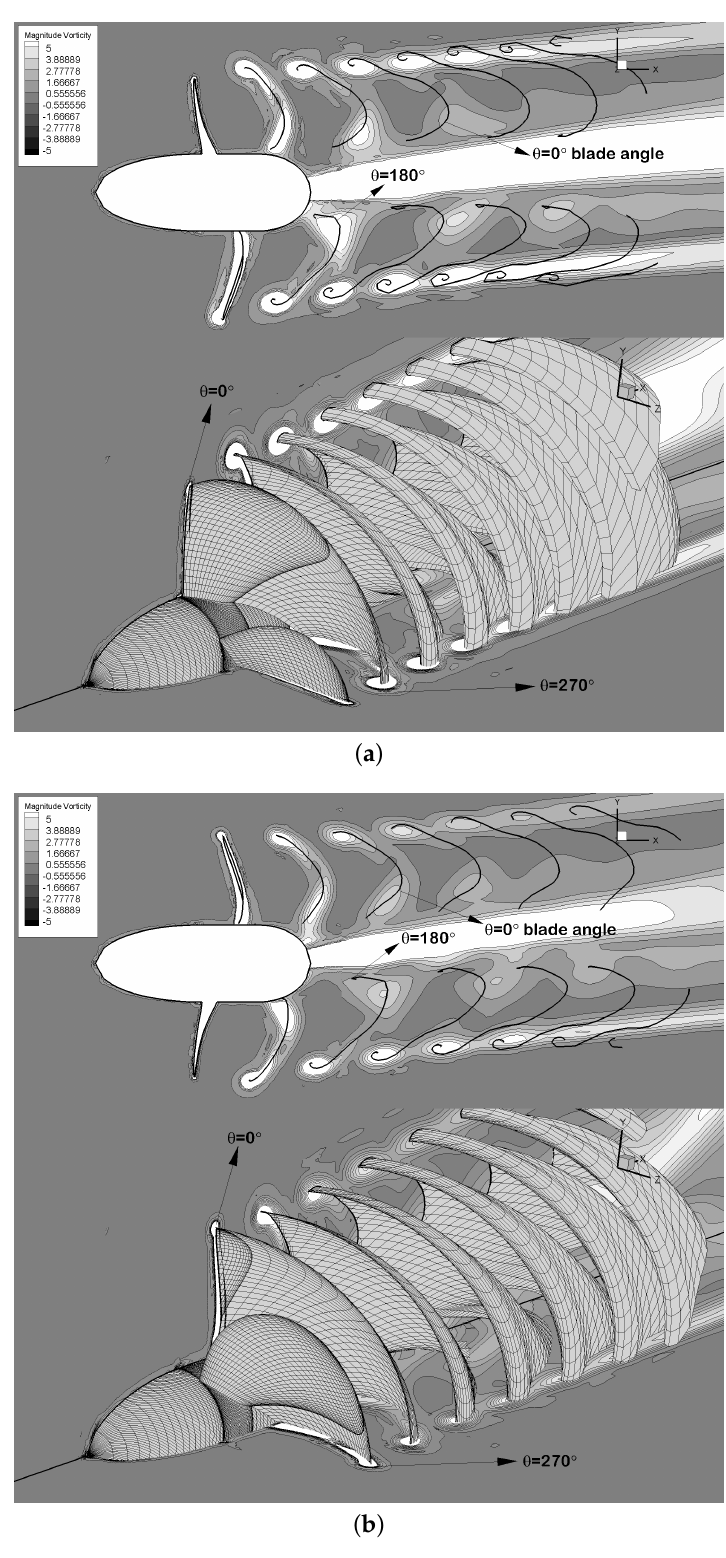
Figure 15. Comparisons of the contour plots showing vorticity magnitude predicted by RANS, and the trailing wake by BEM (black solid line) for the advance ratios of ( a ) 0.8 and ( b ) 1.0. All the shown quantities and wake shapes correspond to the intersection of a vertical and a horizontal planes through the propeller